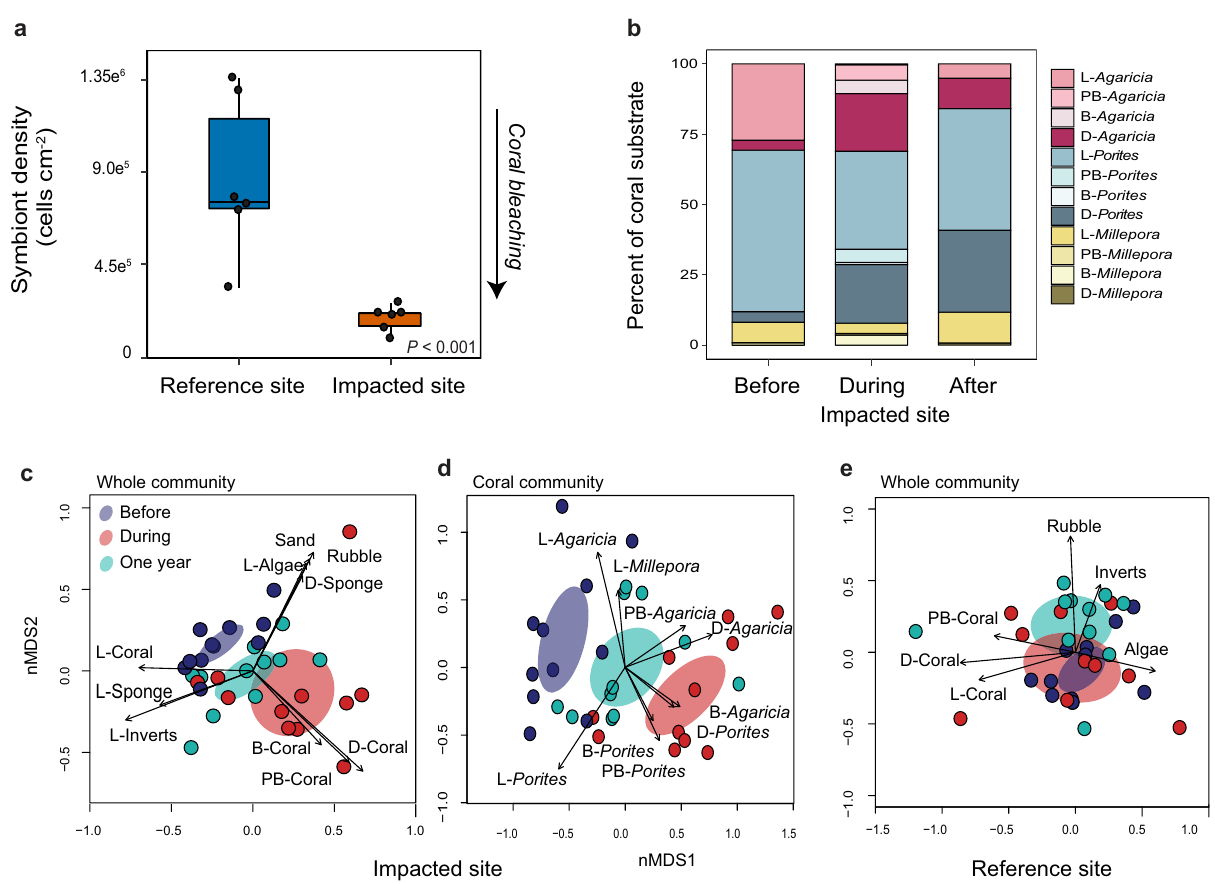
Fig. 2 Deoxygenation event effects on coral bleaching and community structure. a Box plot of Agaricia tenuifolia symbiont densities during the deoxygenation event, with colony means overlaid as black dots ( N = 6 biologically independent colony replicates). The center line indicates the median, the box limits the interquartile range, and the whiskers the minimum and maximum values. The black arrow indicates more coral bleaching with decreasing symbiont densities. Differences between sites were evaluated with linear mixed effects models with site as a fi xed effect and colony as a random effect ( p = 2.143e − 08 ). b Percent cover of all coral substrate for each coral genus and health condition (L — live, B — bleached, PB — partially bleached, D — dead) at the impacted site 4 months before, during, and 1 year after the event from permanent photoquadrat surveys. c nMDS plots showing benthic community assemblages at the impacted site for all functional groups and d for only the coral assemblage. Ellipses indicate the 95% con fi dence interval around the mean assemblage before (blue), during (red), and after (green) the event. Vectors indicate signi fi cant contributions of functional groups ( p < 0.05). e nMDS of the benthic community at the reference site, showing no change during the